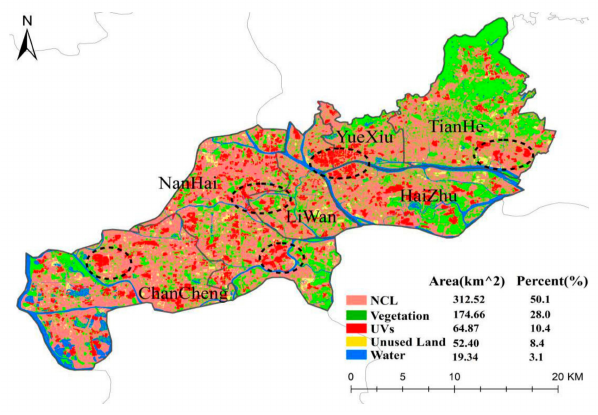
Figure 7. Classification result in the core urban areas of GF.